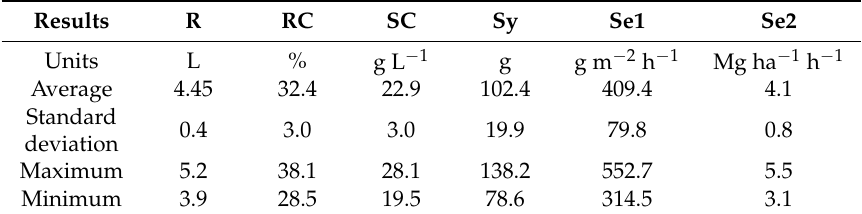
Table 2. Soil erosion results. R: Runoff; RC: Runoff coefficient; SC: Sediment concentration; Sy: Sediment yield; Se1: Soil erosion in g m − 2 h − 1 ; Se2: Soil erosion in Mg ha − 1 h − 1 . Results R RC SC Sy Se1 Se2